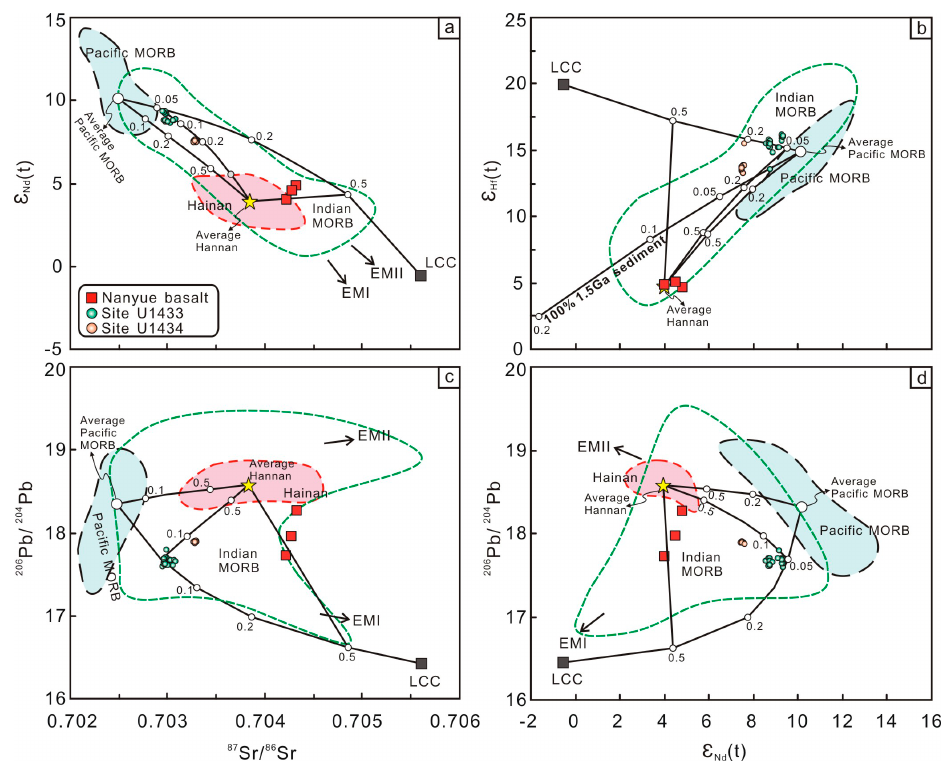
Figure 5. Isotopic plots of: ( a ) ε Nd( t ) versus 87 Sr/ 86 Sr, ( b ) ε Hf( t ) versus ε Nd( t ), ( c ) 206 Pb/ 204 Pb vs. 87 Sr/ 86 Sr, and ( d ) 206 Pb/ 204 Pb versus ε Nd( t ) for the Nanyue basalts. We note that ε Nd and ε Hf were normalized to the 143 Nd/ 144 Nd and 176 Hf/ 177 Hf ratios of the chondrite uniform reservoir (CHUR; 0.512630 and 0.282785, respectively) [34]. Sources of data for comparison: the Pacific MORB and the Indian MORB are from [30] and the Hainan OIB is from [11,12,28,31]. Sources of data used for the end-member mixing calculations: the average isotopic composition of the Hainan OIB is from [11,12,28,31], the average isotopic composition of the Pacific MORB is from [30], and the isotopic composition of the lower continental crust (LCC) is from [35]. Binary lines corresponding to the isotopic compositions resulting from various mixing models are from [5]. Each white dot on the mixing lines represents various increments of melt fractions from the average Hainan OIB, the average Pacific MORB, and the LCC. Data references of enriched mantle (EM)-I and -II end-members are from [36]. Compositional data of volcanic rocks from the IODP Sites U1433 and U1434 are from [5].